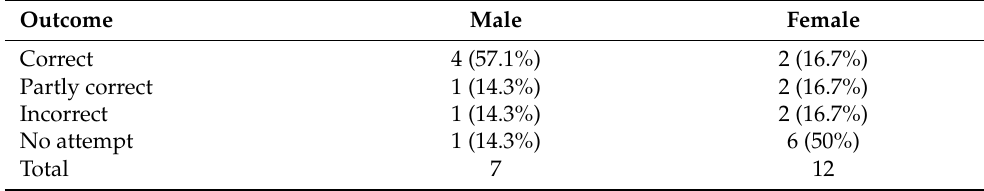
Table 6. Overall performances of students with different genders in the second word problem.